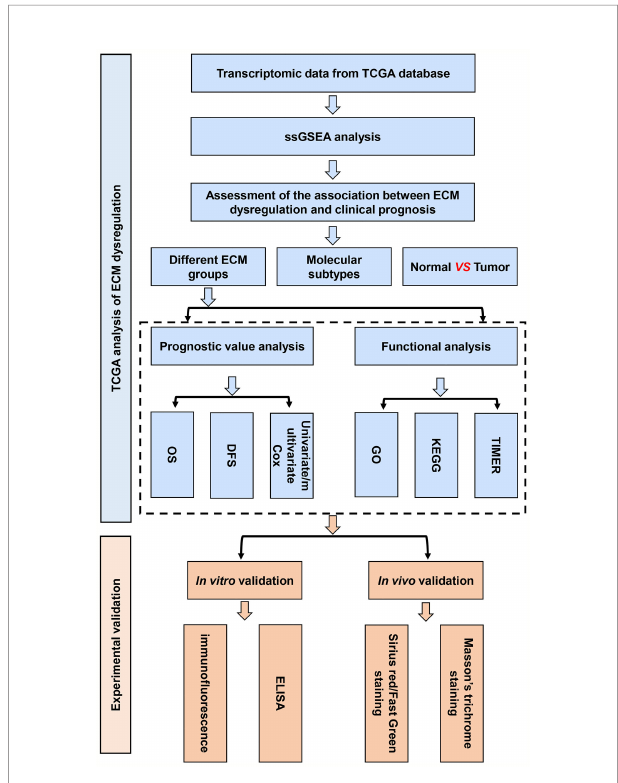
FIGURE 1 | The fl ow chart of construction and validation of data collection and analysis.